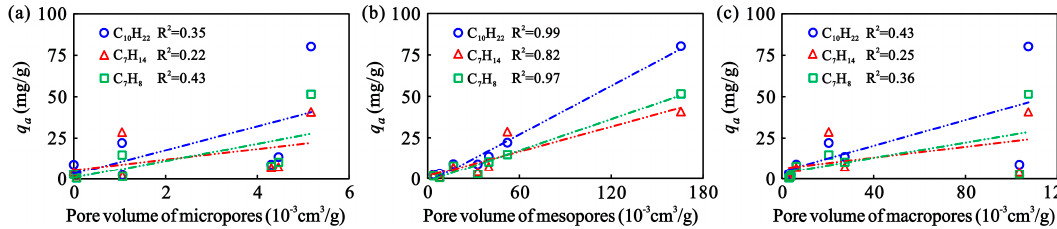
Figure 6. Relationships between the adsorbed amounts ( q a ) and the pore volume of micropores ( a ), mesopores ( b ) and macropores ( c ).